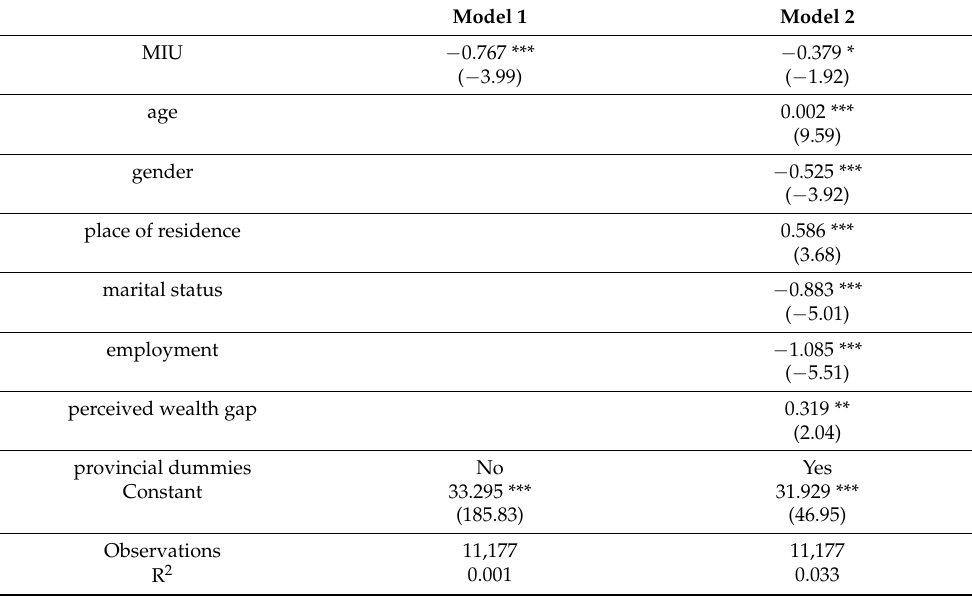
Table 10. Benchmark regression results (16–40 years